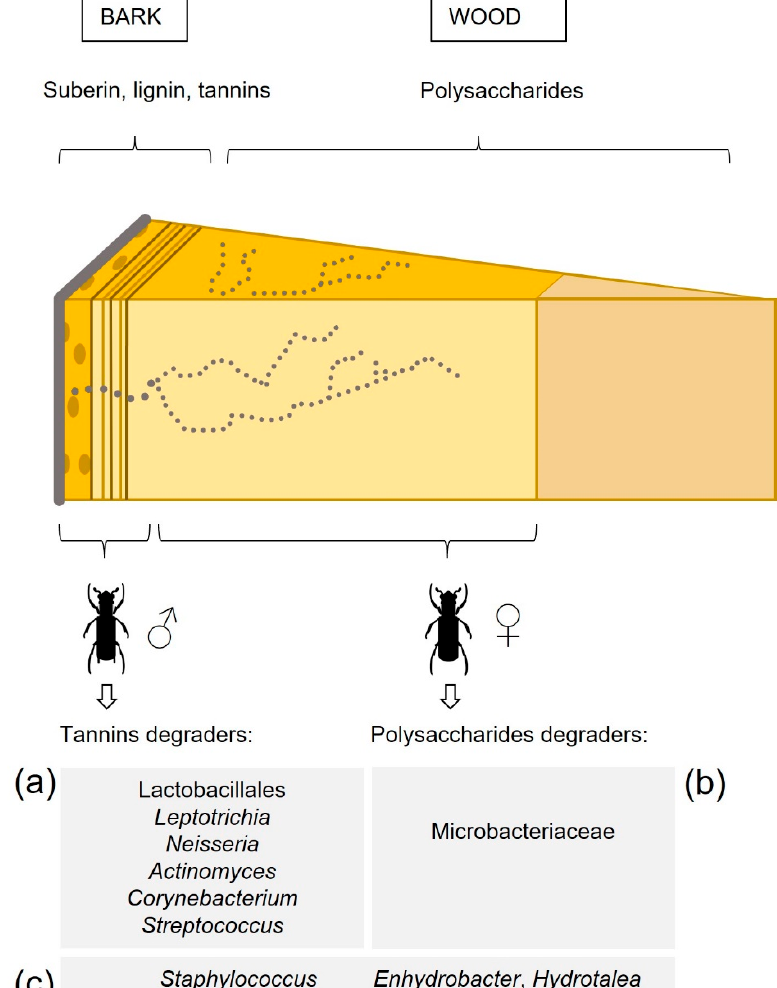
Figure 6. Scheme of a wood section of a Q. suber stem representing galleries of P. cylindrus , and showing the area bored by each sex. Microbiome bacterial taxa reported in the literature as tannins degraders or polysaccharides degraders are organized by having significantly higher relative abundance (Welch’s t-test, p < 0.05) and/or by belonging to the core bacteriome ( a ) of males, ( b ) of females, and ( c ) common to males and females.